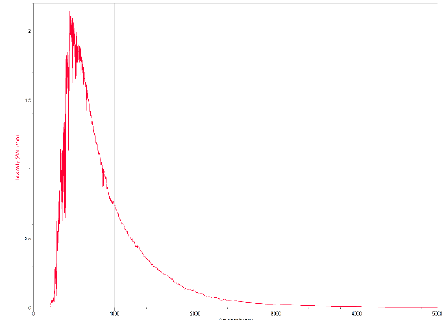
Fig. 2. Spectrum curve of the Sun light measured from space (source: